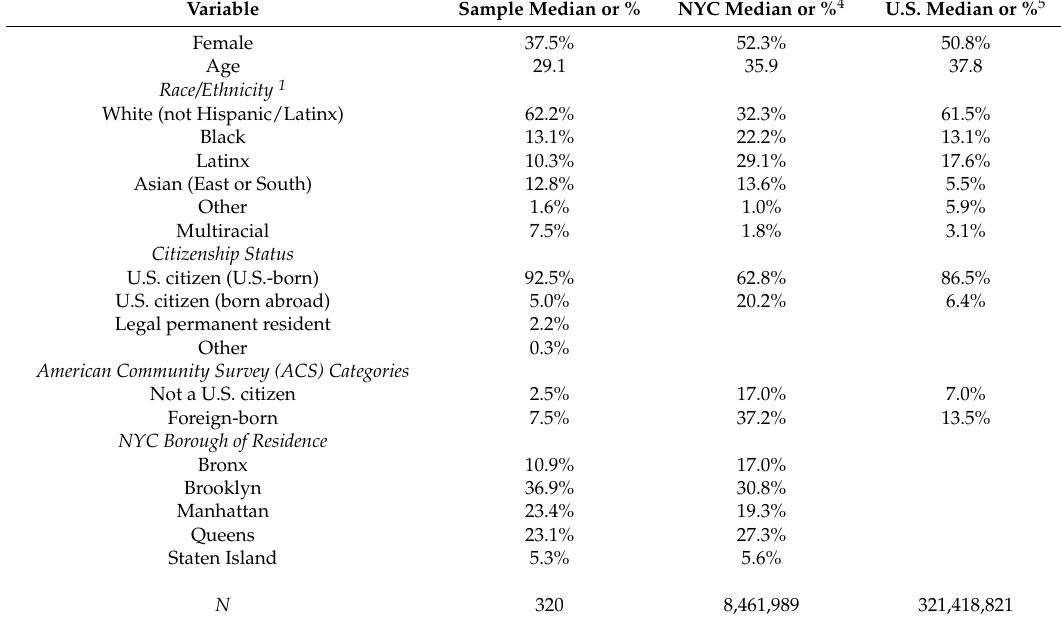
Table 1. Demographics of analytic sample versus New York City (NYC) and U.S.